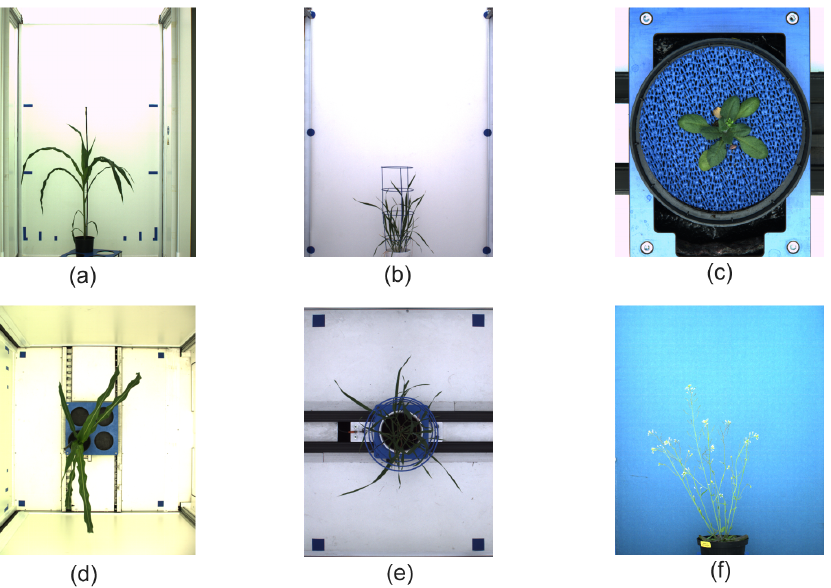
Figure 1. Examples of side-view (upper raw) and top-view (bottom raw) images of maize ( a , d ), wheat ( b , e ) and arabidopsis ( c , f ) plants.